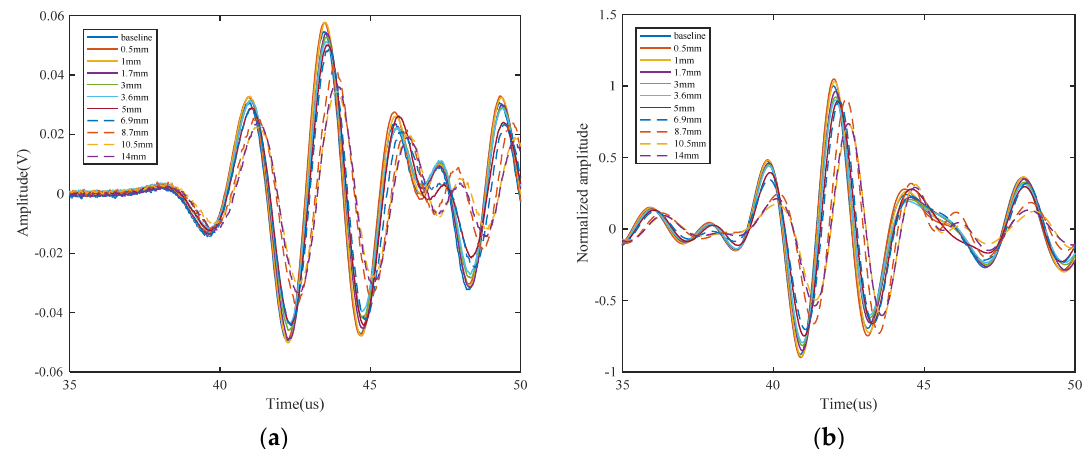
Figure 17. Received waveform of 300~700 kHz L-Chip signal: ( a ) raw signal; and ( b ) the signal processed by dispersion compensation and pulse compression techniques.